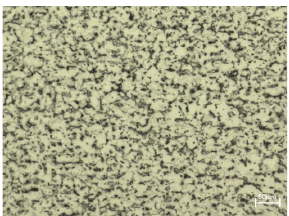
Figure 1. Metallograph of Ti6Al4V alloy. 2.2. Cathode Hydrogen Charging The hydrogen charging samples were cut to a size of 10 mm × 10 mm × 1 mm. Epoxy resin and ethylenediamine mixed in a ratio of 10 to 1 were prepared for the sealing of the samples, leaving a 10 mm × 10 mm test area. The samples ’ surfaces were ground with silicon papers step by step to 2000 grit. The hydrogen-charging experiment was per- formed in 3.5 wt.% NaCl solution prepared with analytical-grade NaCl and deionized water. A standard three-electrode system was adopted, with the sample as the working electrode, a saturated calomel electrode (SCE) as the reference electrode, and a platinum plate as the counter electrode. All the samples were charged for 1 h utilizing a PARSTAT 4000 electrochemical workstation (AMETEK, San Diego, CA, USA) with a constant current density of 100 mA/cm 2 . 2.3. Microstructural Characterization The phase composition of the charged and uncharged samples was determined by using the X-ray diffraction (XRD) method. The XRD experiments were carried out by us- ing a Rigaku SmartLab 9 kw X-ray diffractometer (Rigaku, Tokyo, Japan) with Cu K α ra- diation at 20 kV and 45 mA at a step size of 0.02° and a scan rate of 4°/min. The surface and cross-section morphologies of the charged samples were observed by a scanning elec- tron microscope (SEM, ZEISS MERLIN Compact, Jena, Germany). 2.4. Electrochemical Corrosion Tests All electrochemical corrosion tests were carried out in deep-sea environment simu- lation equipment, in which the HP, DO, temperature, salinity, pH value and mechanical load could be monitored and controlled independently. The electrochemical tests were performed by using an electrochemical workstation (PARSTAT 4000) in a conventional three-electrode cell, with the specimen as the working electrode, a platinum plate as the counter electrode, and an Ag/AgCl electrode as the reference electrode. The potentiody- namic polarization curves were measured at a scan rate of 0.5 mV/s. Electrochemical im- pedance spectroscopy (EIS) was conducted with a sinusoidal potential perturbation of 10 mV and a frequency range from 10 5 to 10 −2 Hz in 3.5 wt.% NaCl solution. All electrochem- ical experiments were performed at pressures of 0.1 MPa, 10 MPa, 30 MPa or 50 MPa, while keeping all other environmental factors unchanged (temperature 5 °C, DO 3.8 ppm). 2.5. SSRT Tests The SSRT samples were prepared with a gauge length of 13 mm using Wire-Cut Elec- trical Discharge Machining (WEDM). After the WEDM process, the samples were hydro- gen-charged. SSRT tests were conducted by the loading device implemented in the deep- sea environment simulation equipment with a strain rate of 2.5 × 10 −5 s −1 . To determine the effect of HP on the SCC behavior of charged samples, SSRT experiments were performed